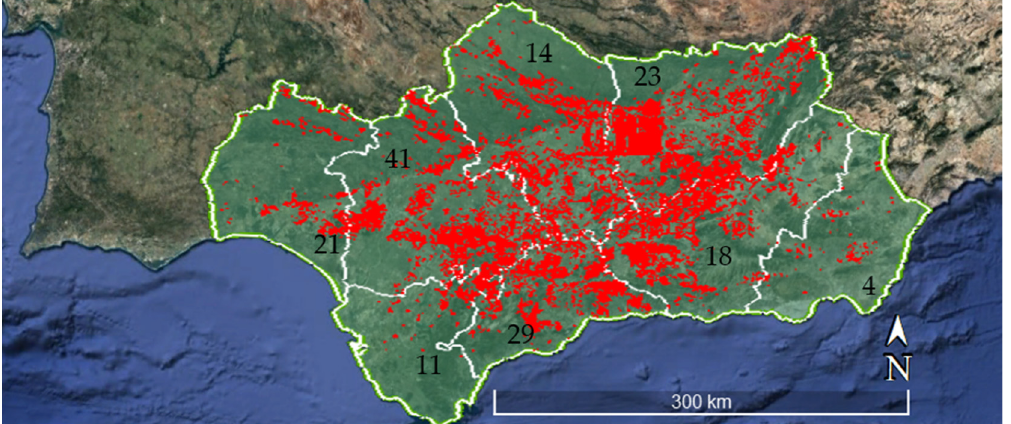
Figure 2. Distribution of hectares where the characterization of olive groves has been carried out. Source: SIGPAC Regional Ministry of Agriculture, Livestock and Fisheries.